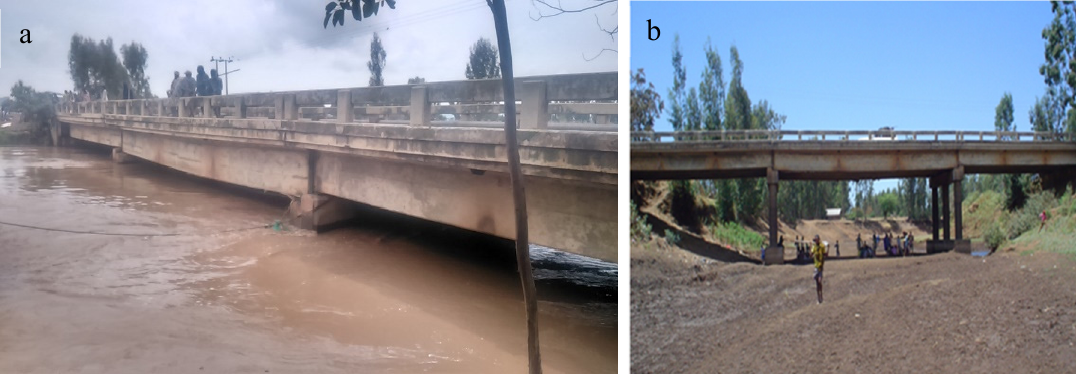
Figure 1. Gumara river at the bridge in the Fogera plain where the road from Bahir Dar to Gondar crosses; ( a ) August 2017 at flood stage during the rain phase and ( b ) February 2015 during the dry season when the flow has ceased (courtesy: M. M.